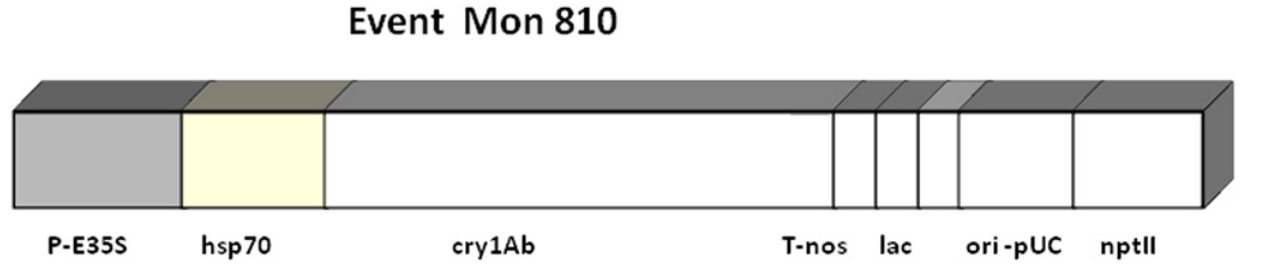
Fig 1. Schematic representation of the Cry1Ab transgene cassette, used in the making of MON810.